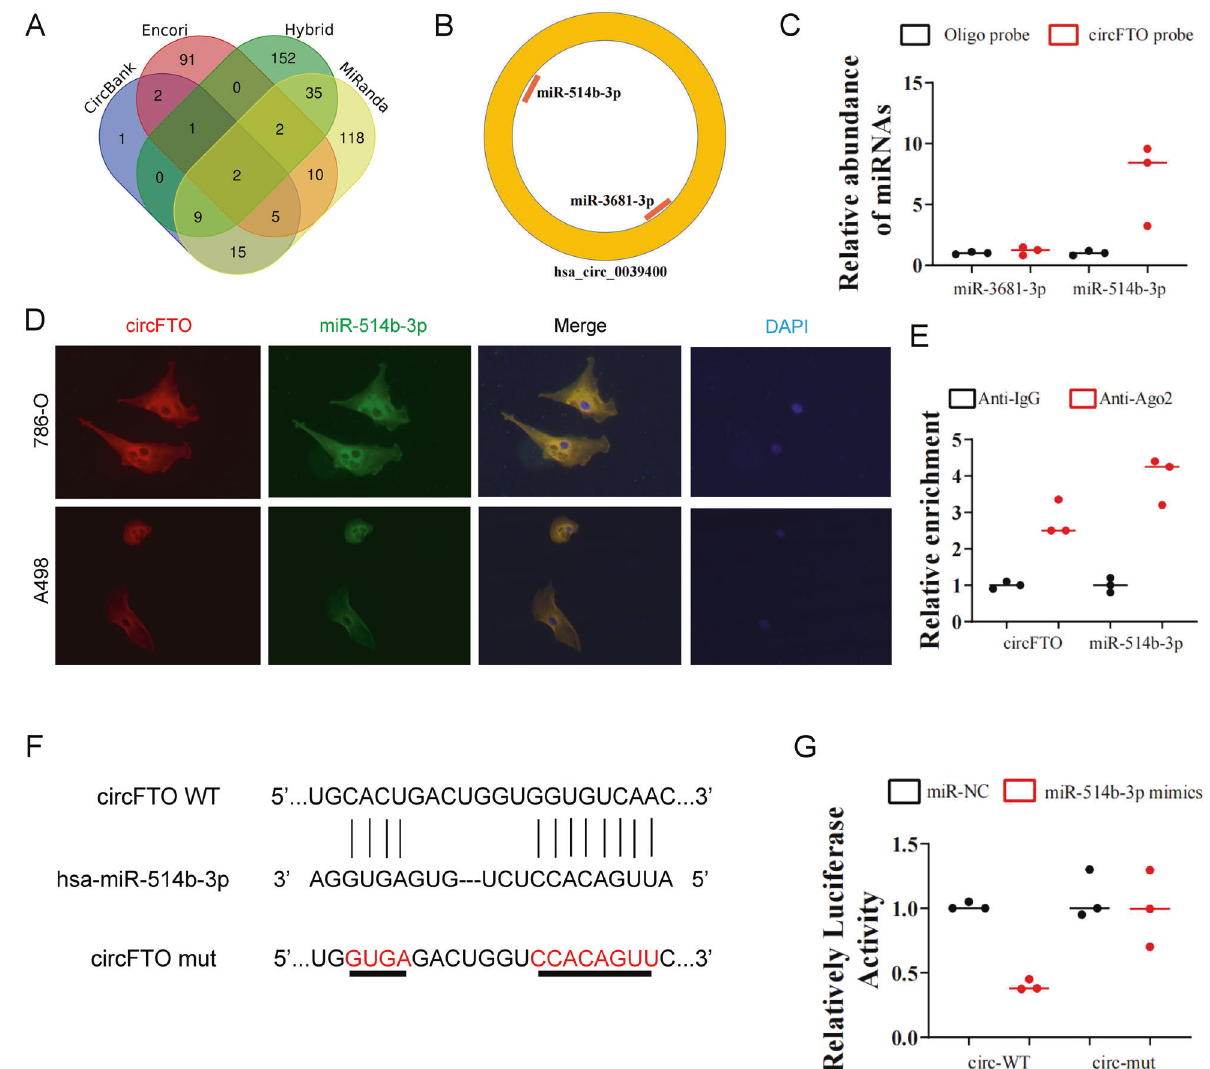
Fig. 3 circFTO serves as the RNA sponge for miR-514b-3p. A and B Prediction of the potential target miRNAs of circFTO with four different datasets circBank, Encori, Hybrid and MiRanda. C RNA pulldown of miR-514-3p and miR-3681-3p in 786-O cells with Oligo or circFTO probe. Relative miRNA expression was detected by qRT-PCR. D Subcellular location of circFTO and miR-514b-3p detected by fl uorescence in situ hybridization (FISH). E RIP against IgG or Ago2 in 786-O cells. Precipitated circFTO and miR-514-3p were detected by qRT-PCR. F The designs of dual-luciferase reporter vector of wild-type (WT) and mutated (Mut) circFTO sequences with binding site to miR-514b-3p. G Relative luc activity after transfection with miR-514b-3p mimic/negative control or with the circFTO WT/Mut in HEK293T